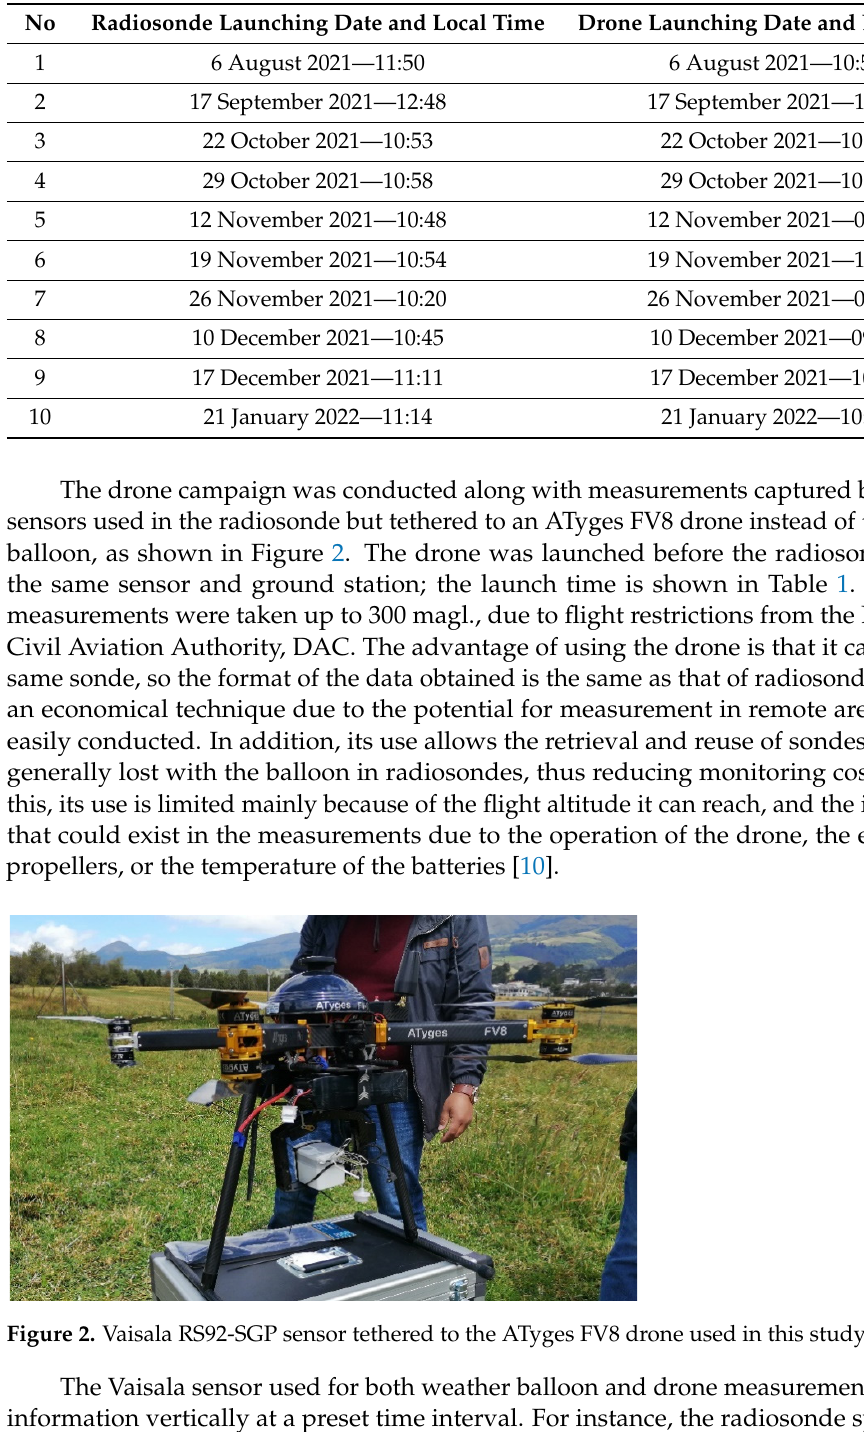
Table 1. Weather Research and Forecasting (WRF) model configuration.